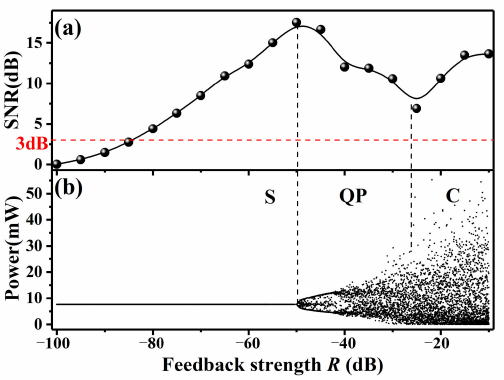
Figure 3. ( a ) The SNR of the frequency-resonance method versus R under 2 I th bias current, and ( b ) a bifurcation diagram of the laser with variable R .